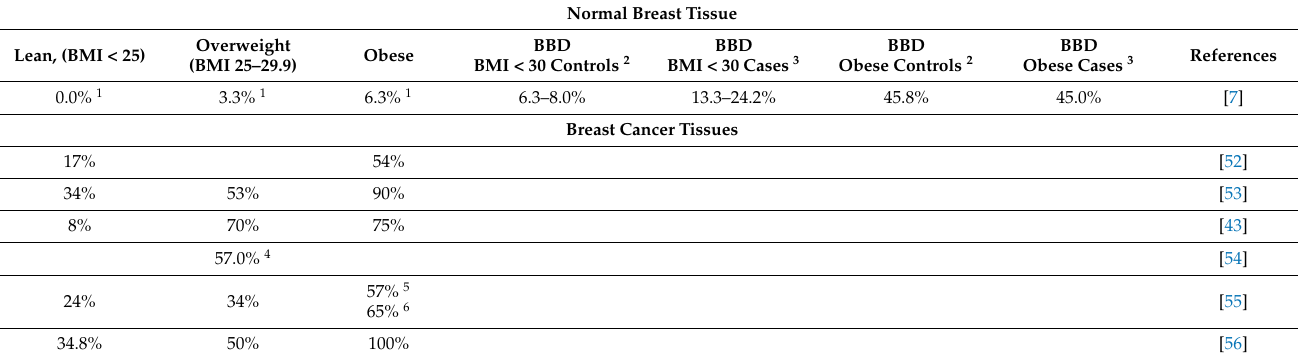
Table 1. Incidence of crown-like structures in breast adipose tissue according to body weight status. Normal Breast